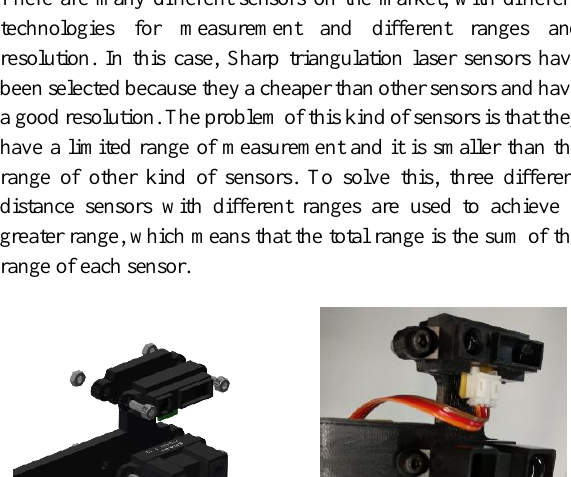
Figure 4. Presentation view of the Payload